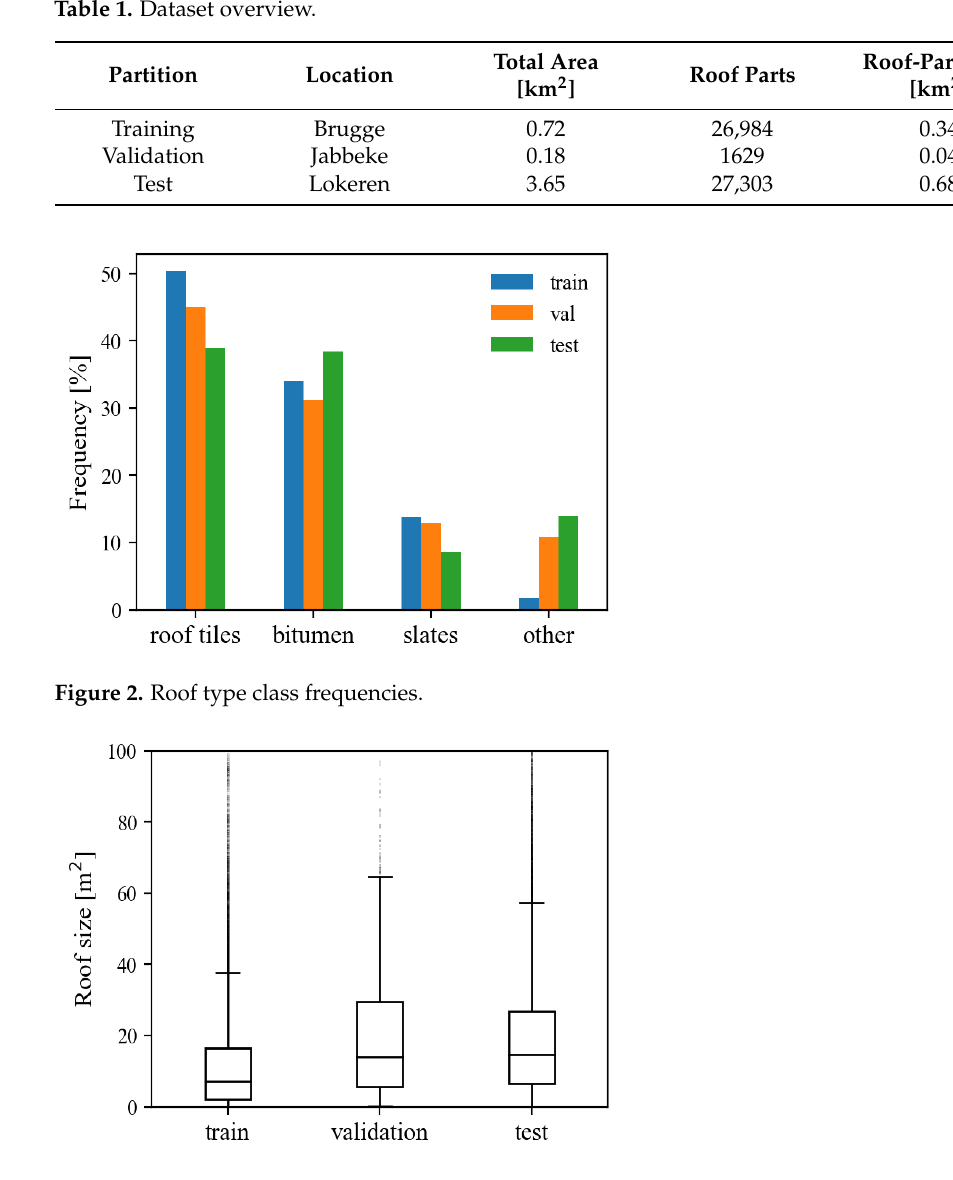
Figure 3. Roof size